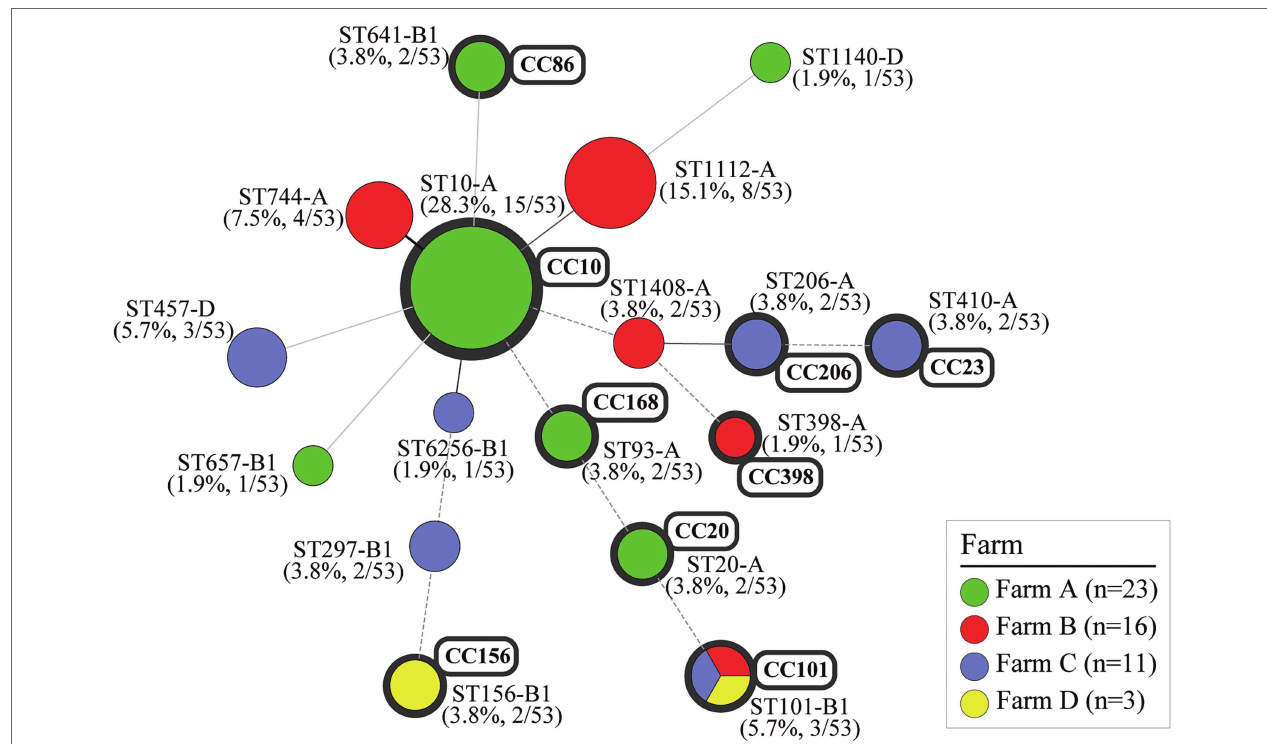
FIGURE 6 | Clonal distribution of MCR1-EC isolates: Minimum spanning tree (MST) based on MLST allele profiles. The MST was constructed using the Bionumerics program (v6.6). The colors of nodes correspond to the four swine farms. The upper number shows the sequence type of each node, and the lower number in parentheses indicates percentages for each node. The size of the node indicates the number of strains belonging to the sequence type (ST)-phylogroup (PG) type. The gray shaded area represents the clonal complex (CC). The branch line types represent differences in the number of alleles as follows: bold solid line (one allele), thin solid line (2–3 alleles), dashed line (four alleles), and dotted line (above five alleles). MCR1-EC, Escherichia coli carrying the mobilized colistin resistance gene mcr-1.1 ; MLST, multi-locus sequence